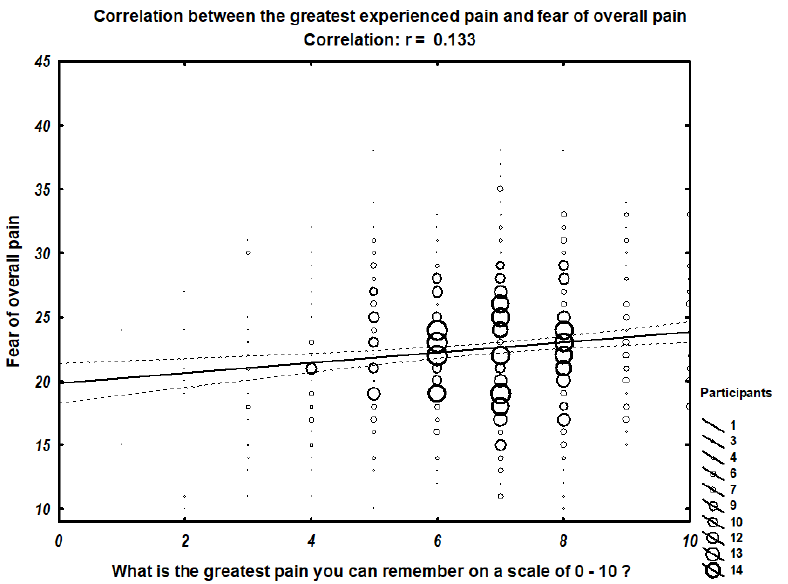
Figure 3. Correlation between the greatest experienced pain and fear of overall pain.